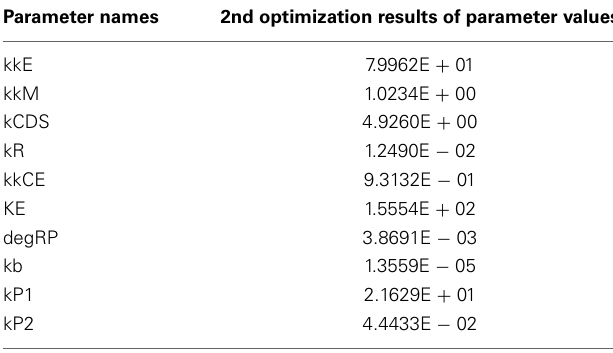
cross: experimental result), lower panel shows phosphorylated (brown line), dephosphorylated (green line) and their sum (black line) of simulation results, with experimental result (black cross). The fitting to the experimental data was repeated for the three species after the 1st set of parameter optimization.